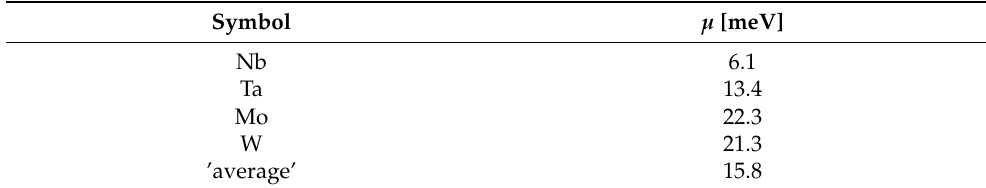
Table 2. The chemical potential energies of pure elements and the average alloy computed in the context of the pure metals. The ’average’ represents the weighted average of chemical potential energies of Nb, Ta, Mo, and W.